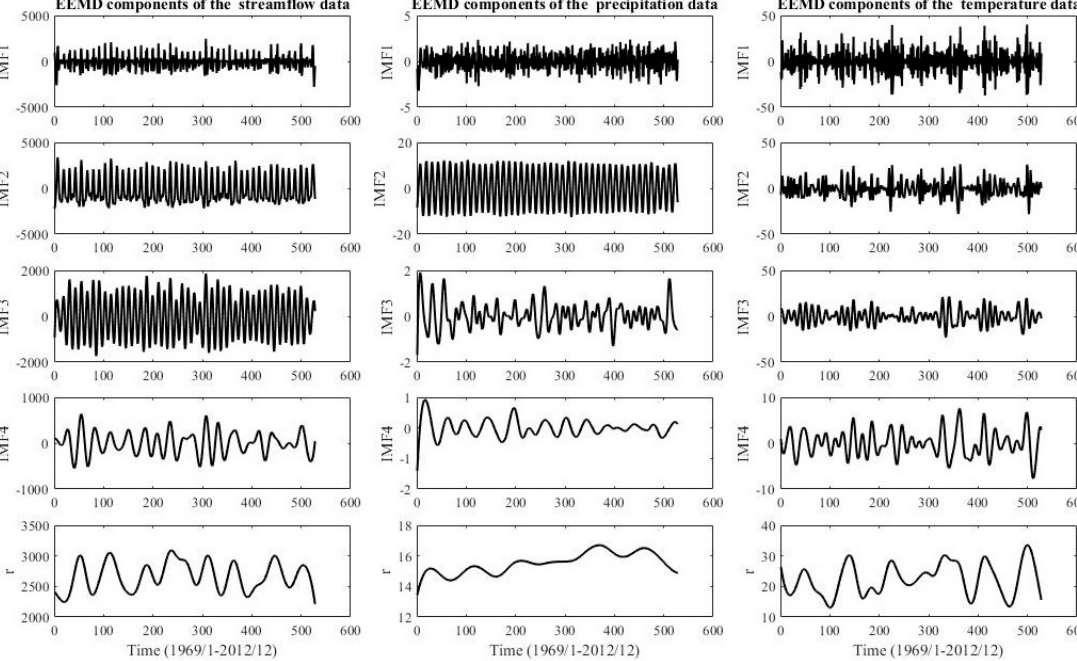
Figure 8. Zone Two: streamflow, precipitation, and temperature data are decomposed by EEMD.